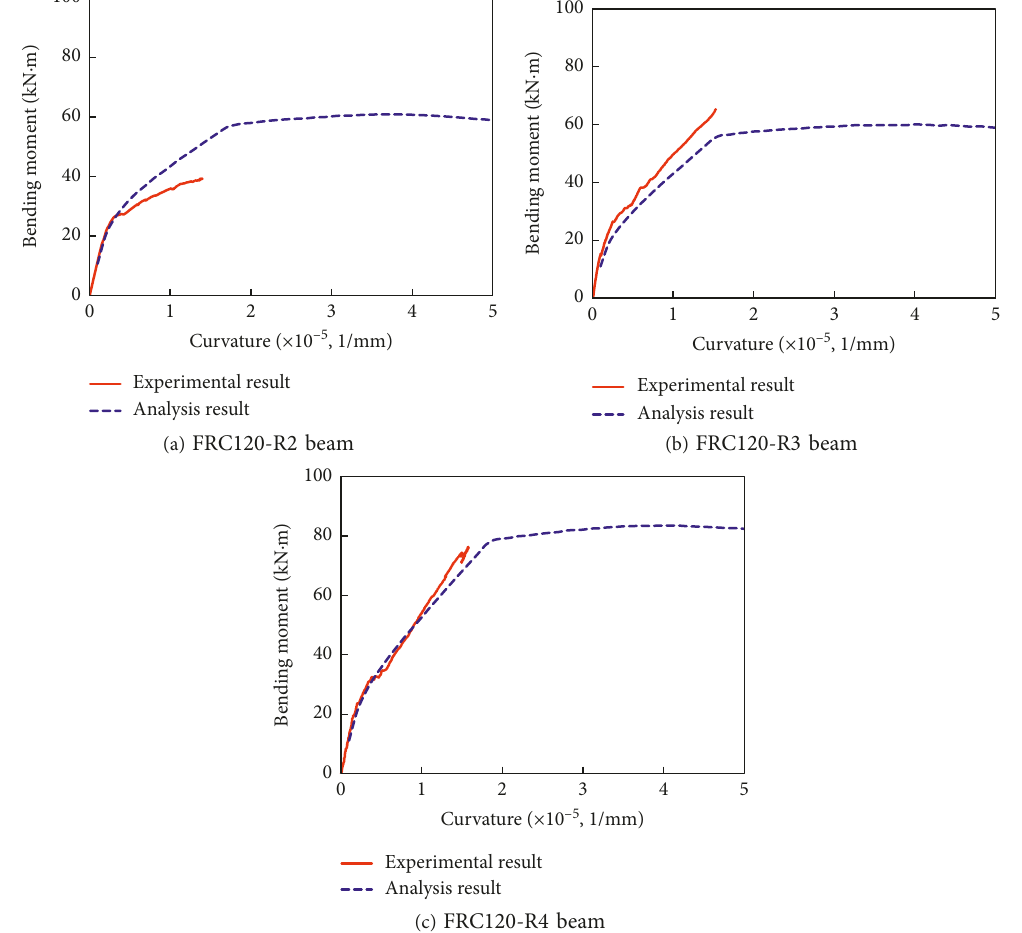
Figure 12: Prediction of moment-curvature curves (FRC120 series